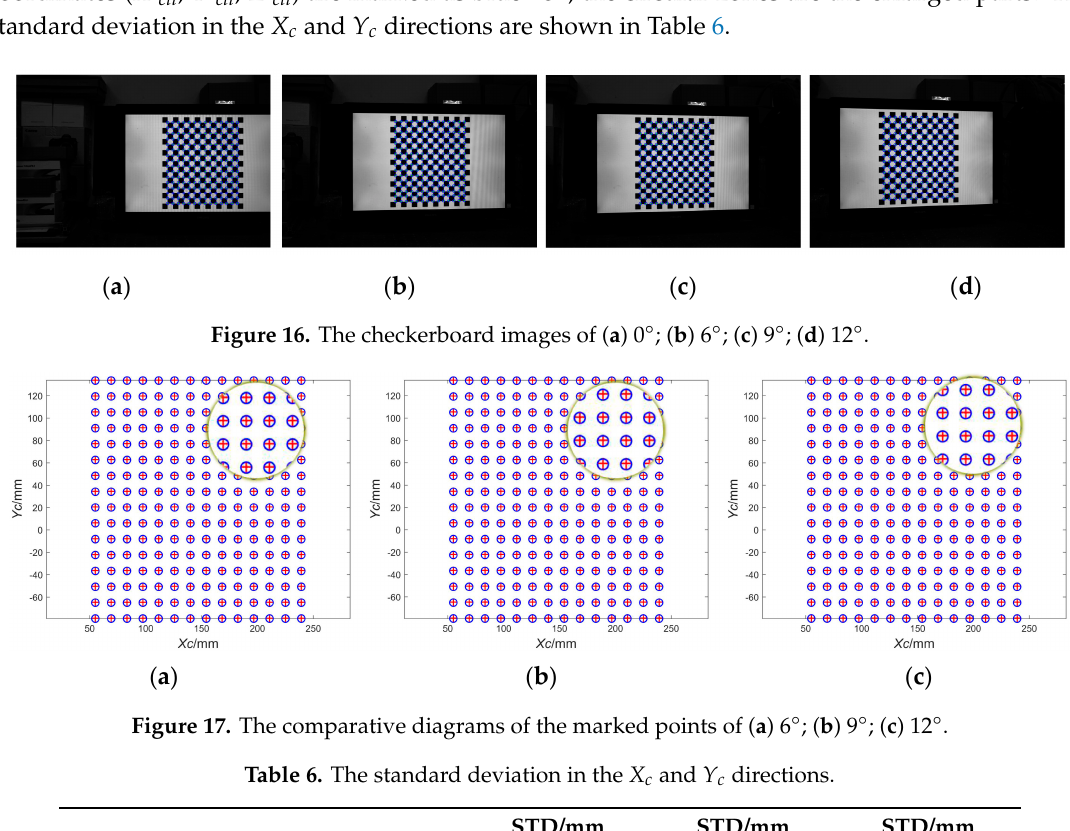
Figure 18. The checkerboard images of ( a ) 0°; ( b ) 6°; ( c ) 9°; ( d ) 12°.